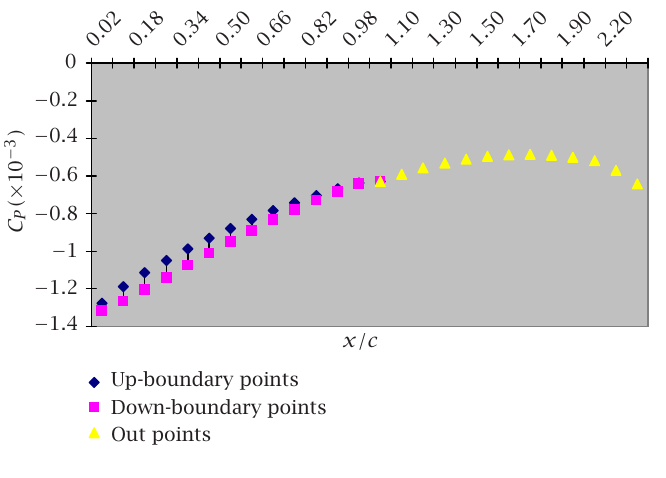
Figure 6.1 . Pressure distribution around the aircraft of Figure 5.1, for linear vortex distribution and speed 1Mach.